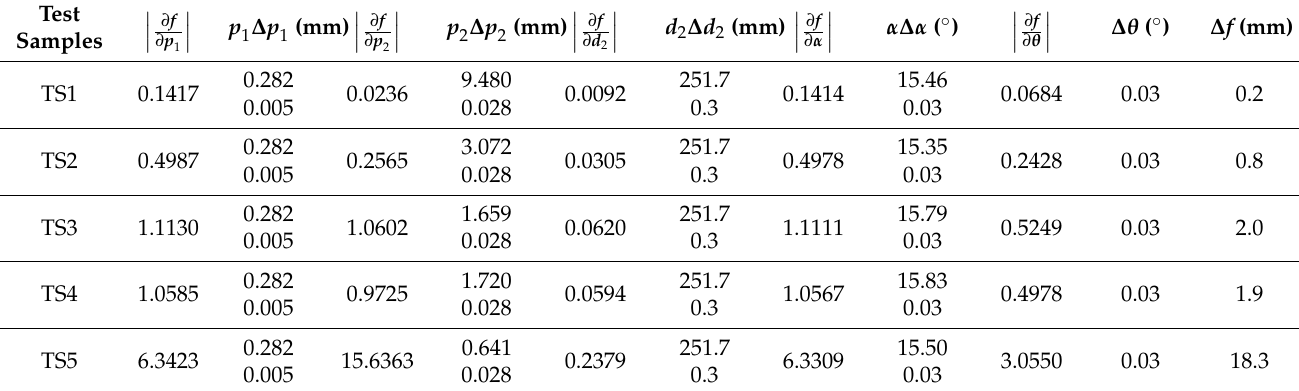
Figure 7. Schematic of the evaluation of ( a ) angle and ( b ) angle deviation on a digital image. Therefore, with Equation (20), considering the digital image with 1200 × 1200 pixels ( K = J = 1200) in Figure 6, the angle deviations of ∆ α and ∆ θ equal to 0.03 ◦ . According to Equation (13), the measurement uncertainty ∆ f of the focal length for TS1–5 can be evaluated with values of 0.2, 0.8, 2.0, 1.9, 18.3 mm, respectively. The values of relevant terms, parameters, and measurement uncertainty ∆ f are summarized in Table 2. In order to clarify the large measurement uncertainty of TS5, from Equations (14)–(18), we can find that when p 1 and p 2 have close values, the term of [ p 1 (tan α sin θ + cos θ ) − p 2 ] 2 in the denominator ∼ = will magnify introduced errors of ∆ p 1 , ∆ p 2 , ∆ α , and ∆ θ (due to tan α sin θ + cos θ 1, when α ∼ = 15 ◦ and θ = 30 ◦ ). By contrast, in the cases of TS1 and TS2, p 2 has a value much larger than p 1 (>>1), therefore the measurement uncertainty can reach sub-millimeter. Table 2. Values for relevant terms and parameters for the measurement uncertainty of focal